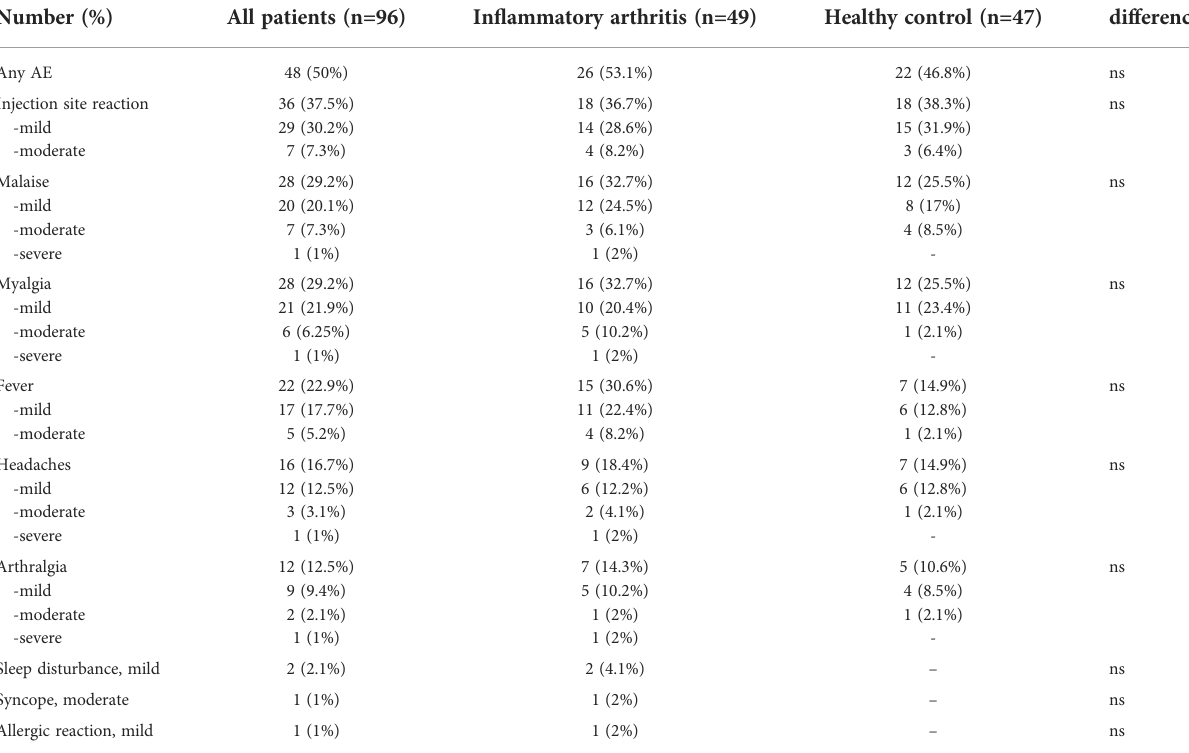
TABLE 4 Adverse events (AE) after primary vaccination in in fl ammatory arthritis patients and healthy controls. Number